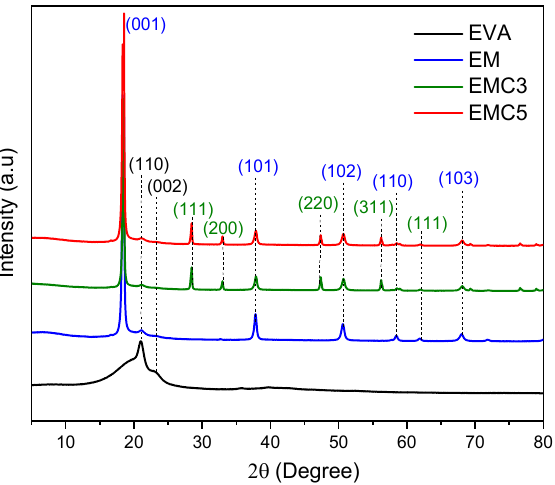
Figure 3. XRD spectra of the EVA-MDH-CeO 2 composite materials.